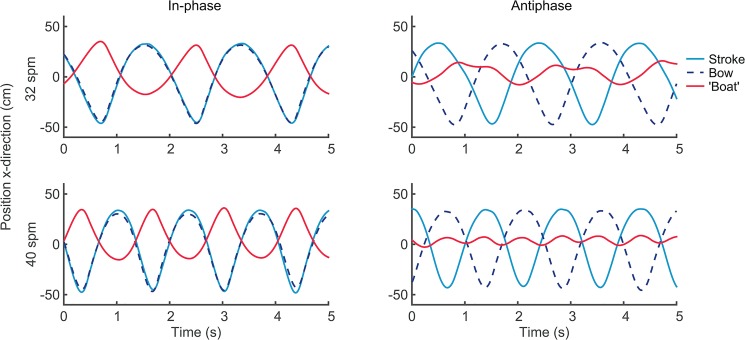
Example of movements of rowers and ‘boat’.Example of in-phase (left panels) and antiphase (right panels) crew coordination at 32 spm (upper panels) and 40 spm (lower panels).